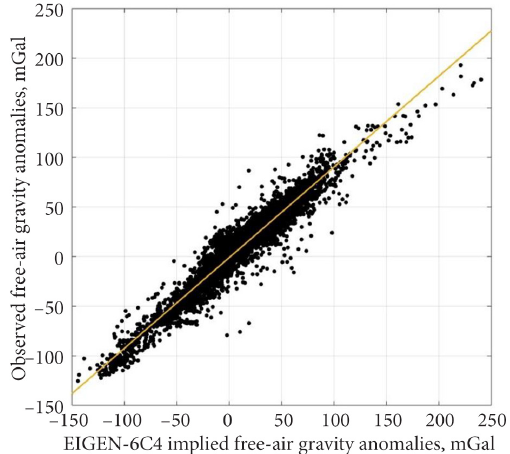
Figure 5. Correlation between observed and EIGEN-6C4 implied free-air gravity anomalies over Kenya at 8,690 gravity data